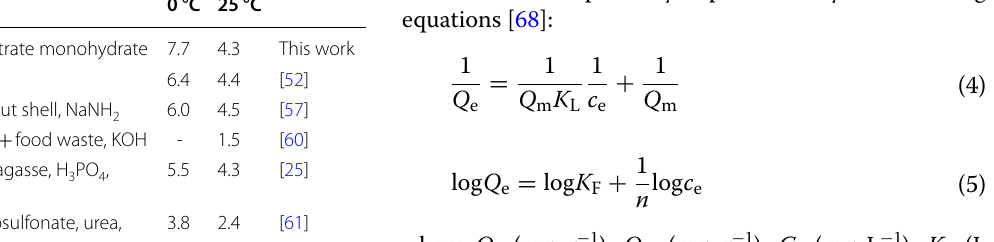
Table 4 Comparison of the CO prepared adsorbent with the reported materials Adsorbents Raw